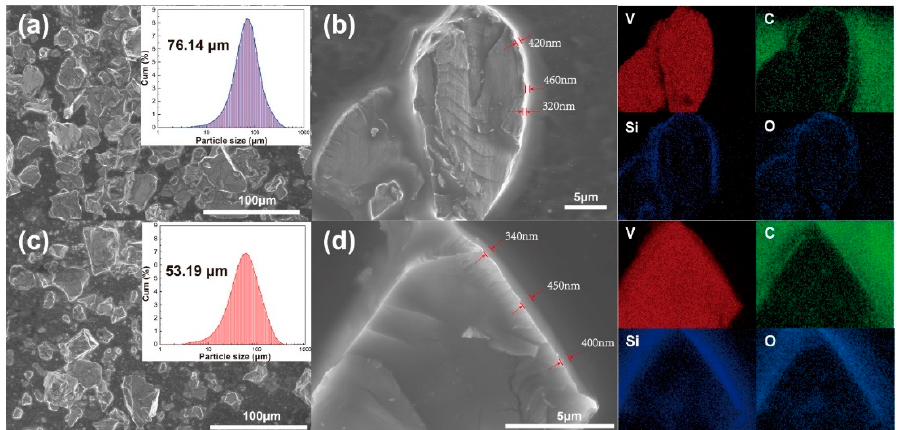
Figure 5. ( a , c ) SEM images of sample s 3 and ( b , d ) EDS mapping images of selected particles after the 1st and the 20th cycle. Insets of ( a , c ) display the particle size distribution.